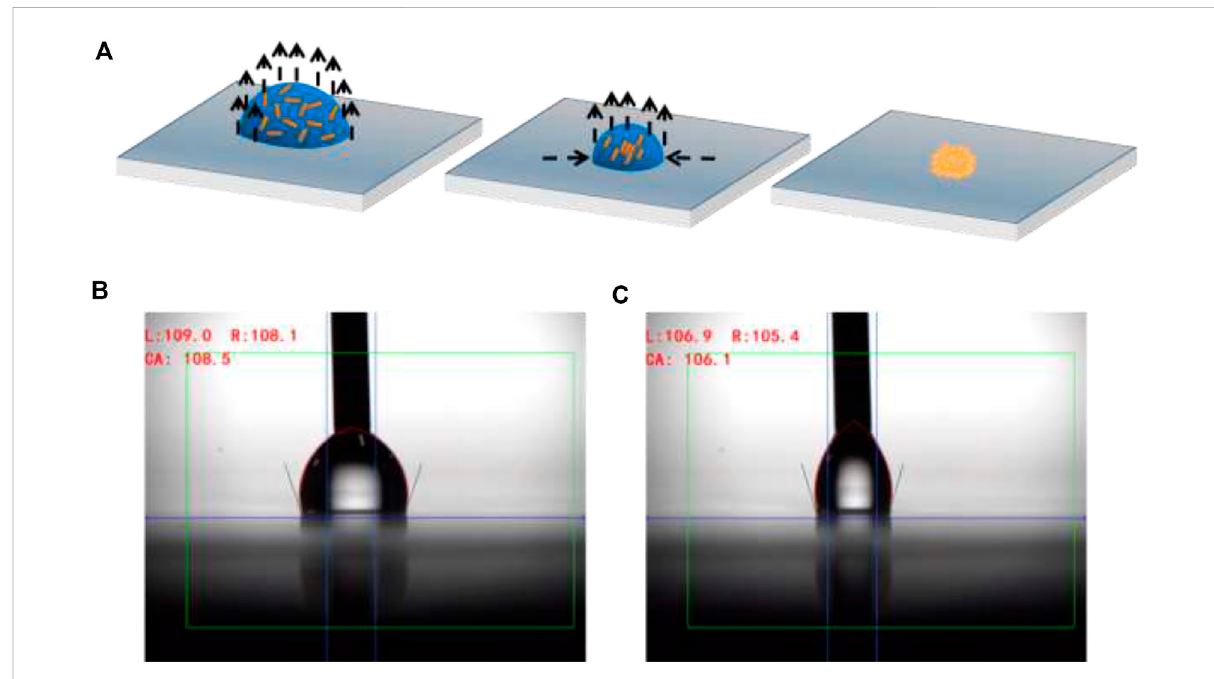
FIGURE 1 (A) A diagramshowingtheenrichmentand self-assemblyofGNRson ahydrophobic surface. (B) Contact anglesadvancingand (C) recedingon a hydrophobic